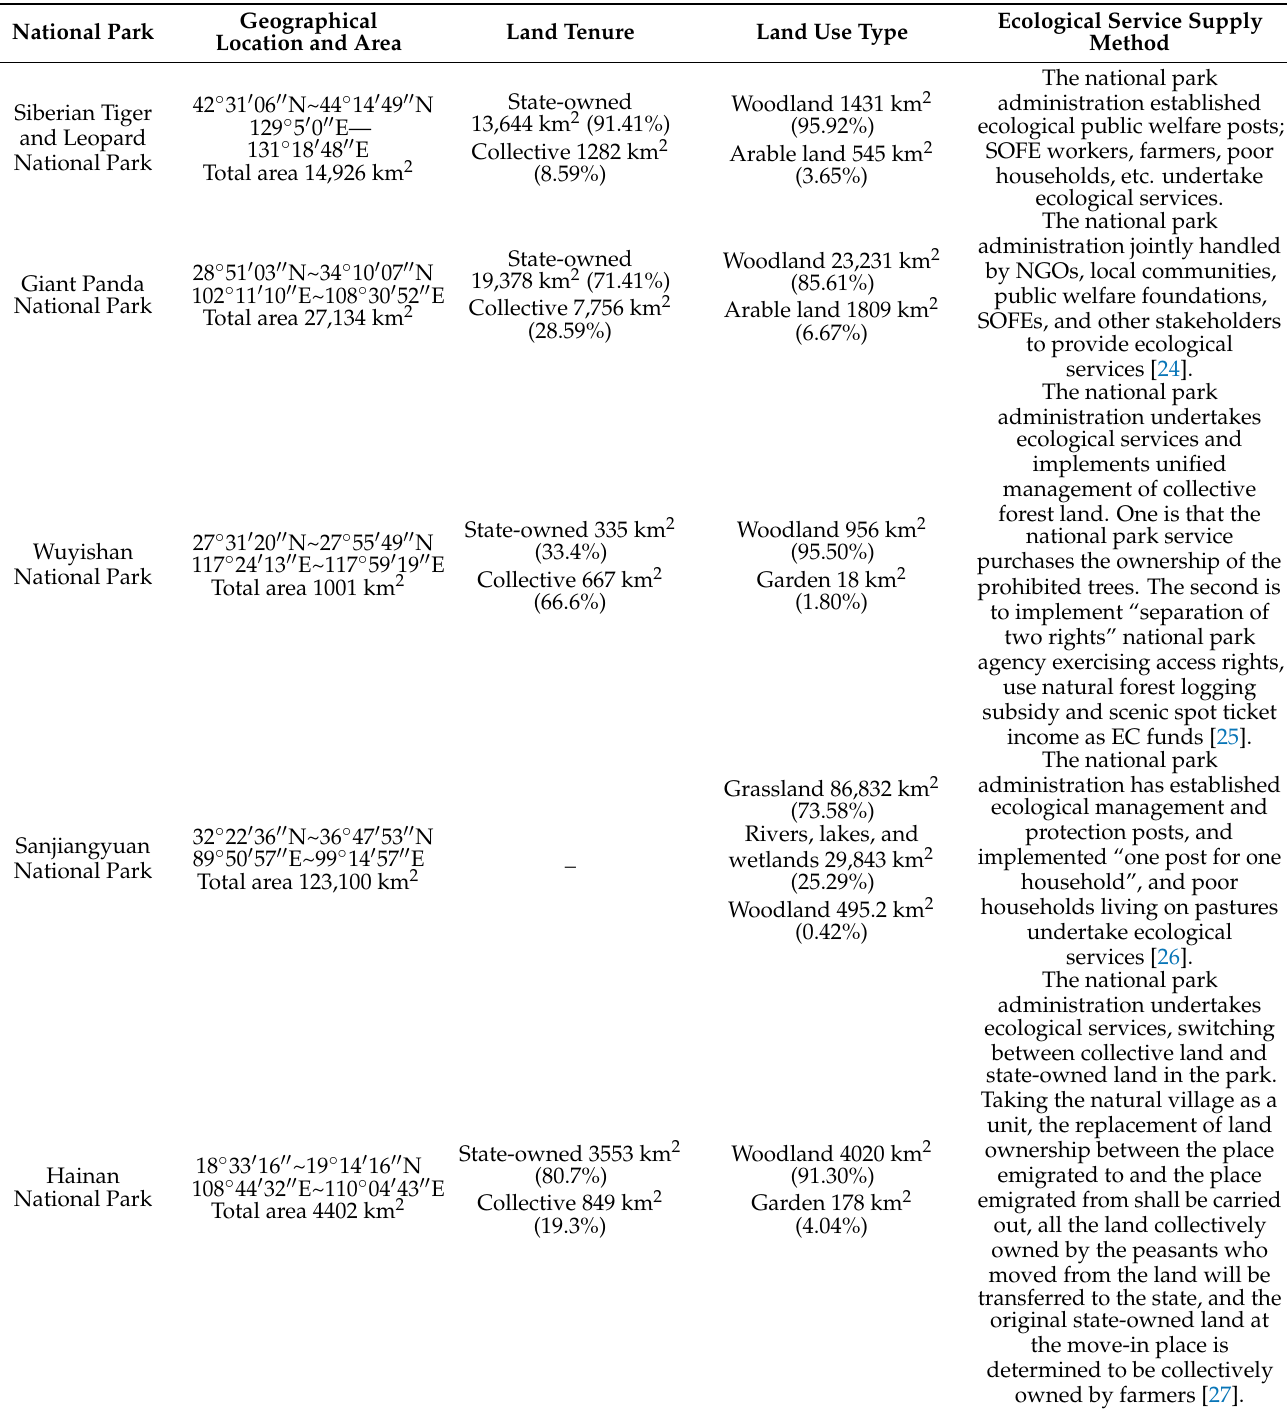
Table 1. Overview of China’s officially established national